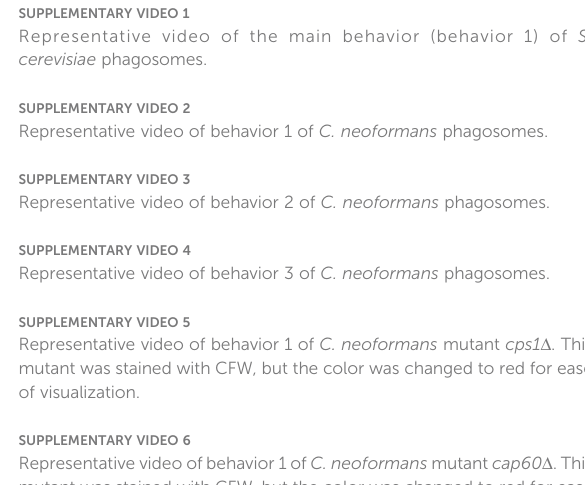
SUPPLEMENTARY VIDEO 3 Representative video of behavior 2 of C. neoformans phagosomes. SUPPLEMENTARY VIDEO 4 Representative video of behavior 3 of C. neoformans phagosomes. SUPPLEMENTARY VIDEO 5 Representative video of behavior 1 of C. neoformans mutant cps1 D . This mutant was stained with CFW, but the color was changed to red for ease of visualization. SUPPLEMENTARY VIDEO 6 Representative video of behavior 1of C. neoformans mutant cap60 D . This mutant was stained with CFW, but the color was changed to red for ease of visualization. SUPPLEMENTARY VIDEO 7 Representative video of behavior 1 of yeast-locked C. albicans mutant. This mutant was stained with CFW, but the color was changed to red for ease of visualization. Interestingly, the pHrodo dye (green) seems to be inherited by the growing bud, whereas CFW (red) is retained in the mother cell.